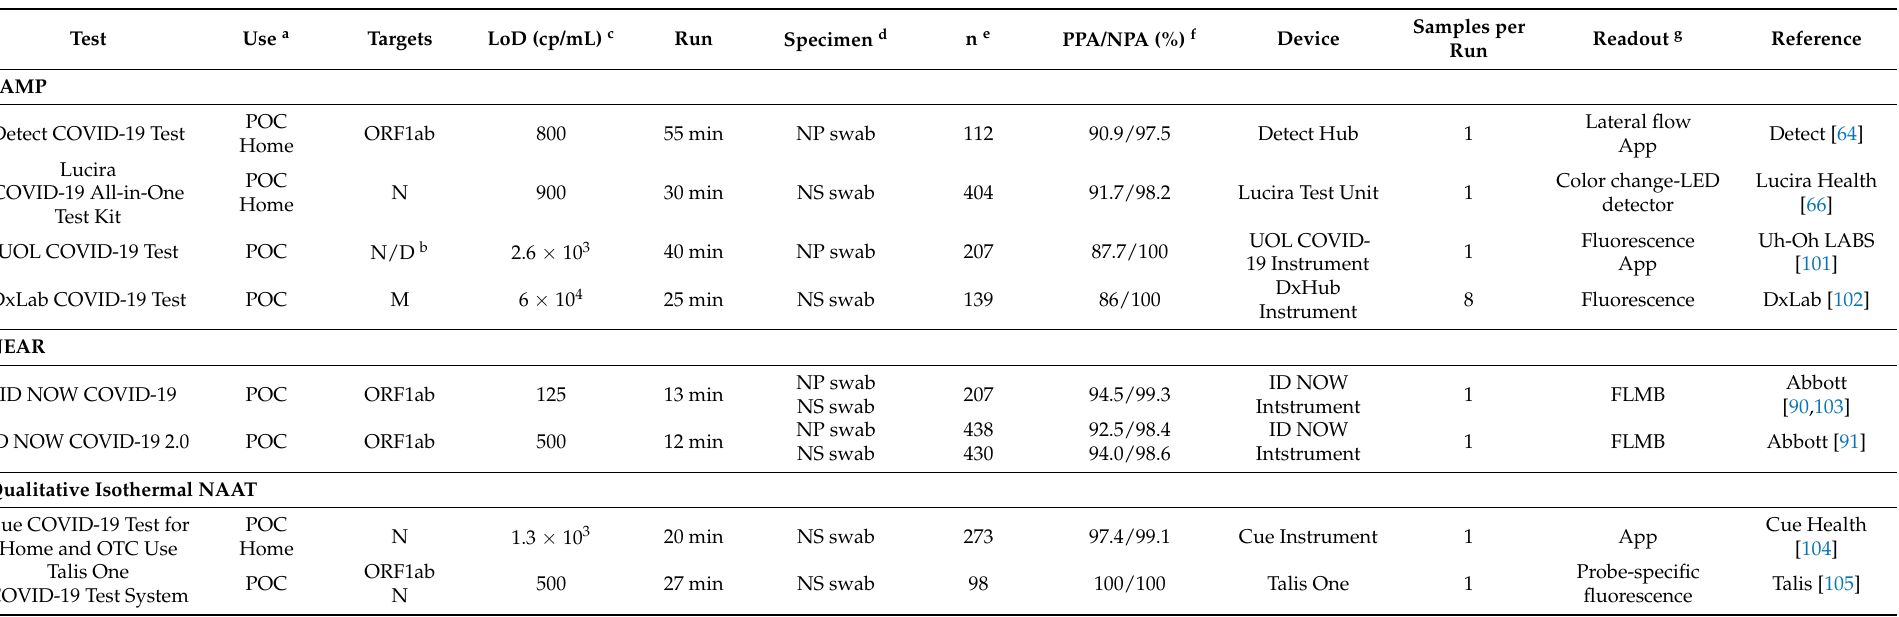
Table 3. Isothermal amplification tests for SARS-CoV-2 detection approved for use under a Clinical Laboratory Improvement Amendments (CLIA)